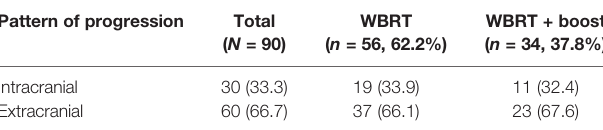
TABLE 4 | Patterns of failure in 90 patients after WBRT or WBRT + boost.